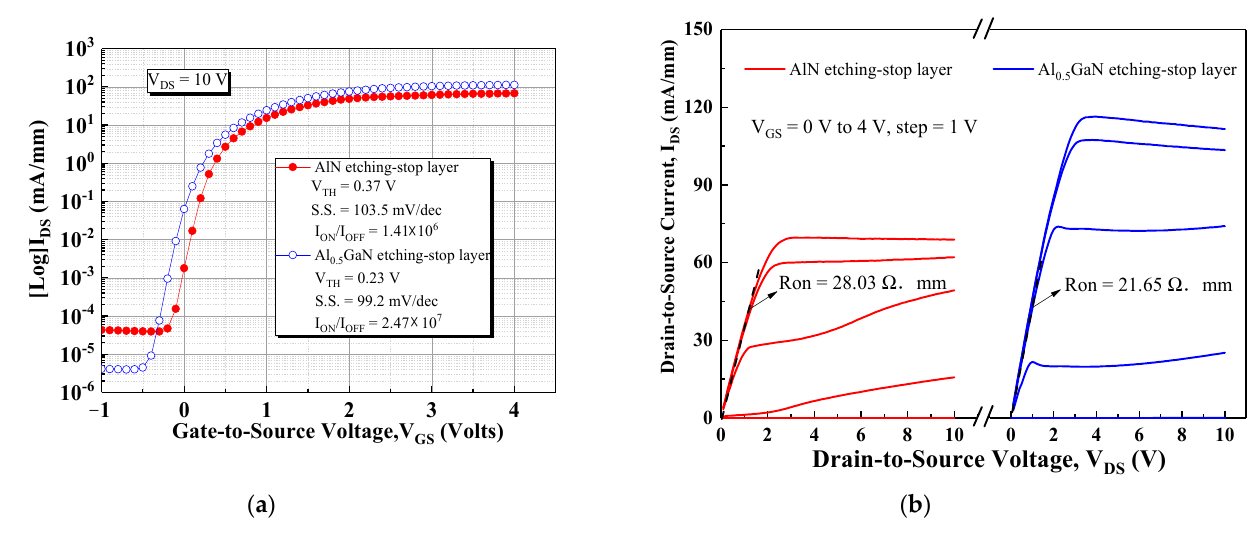
Figure 3. I–V characteristic comparison of both devices (device dimension: L GS /L G /L GD /W G = 2 μ m/2 μ m/5 μ m/100 μ m). ( a ) Transfer characteristics and ( b ) output characteristics. The gate leakage curve presented in Figure 4a was used to investigate the leakage current mechanism. The device with the Al 0.5 GaN etch-stop layer exhibited a lower gate leakage current than did the other device. This low gate leakage current not only increased the device breakdown voltage but also improved the gate operator voltage. The off-state breakdown voltage ( V BR ) was measured using an Agilent B1505 analyzer; the V GS was 1V and the drain leakage current reached 1 mA/mm. As displayed in Figure 4b, the V BR values of the devices with the AlN and Al 0.5 GaN etch-stop layers were 501 and 561 V, respectively. Moreover, Baliga’s figure of merit ( BFOM = V BR 2 / R DS _ on ) for various power transistors was calculated to evaluate the overall performance of these devices [16,17]. The BFOM values of the devices with the AlN and Al 0.5 GaN etch-stop layers were 44.37 and 83.11 MW/cm 2 , respectively.